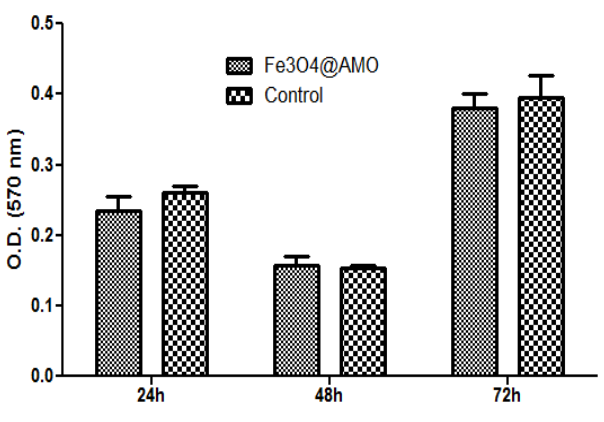
O @AMO for 24, 48 and 72 h. 3 4